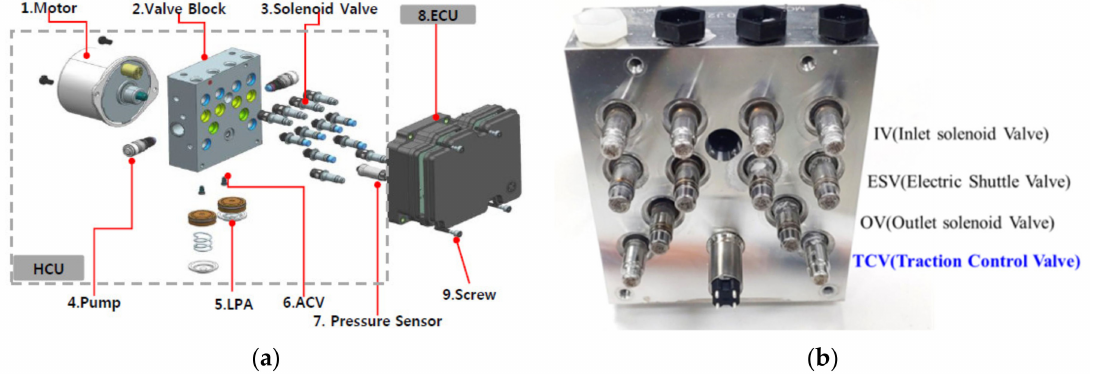
Figure 1. Configuration of the ESC: ( a ) Structure of ESC; ( b ) Solenoid valves of the ESC.